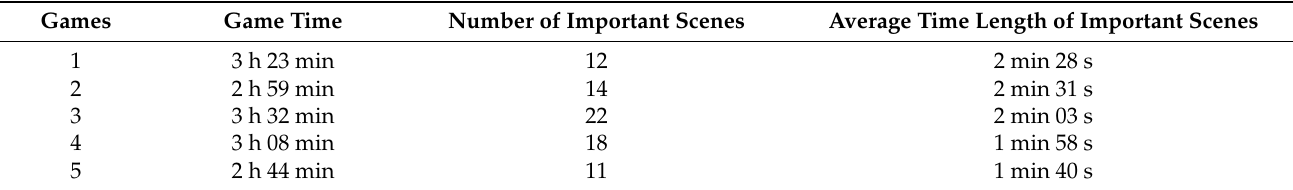
Table 1. Details of the baseball videos used in the experiment.